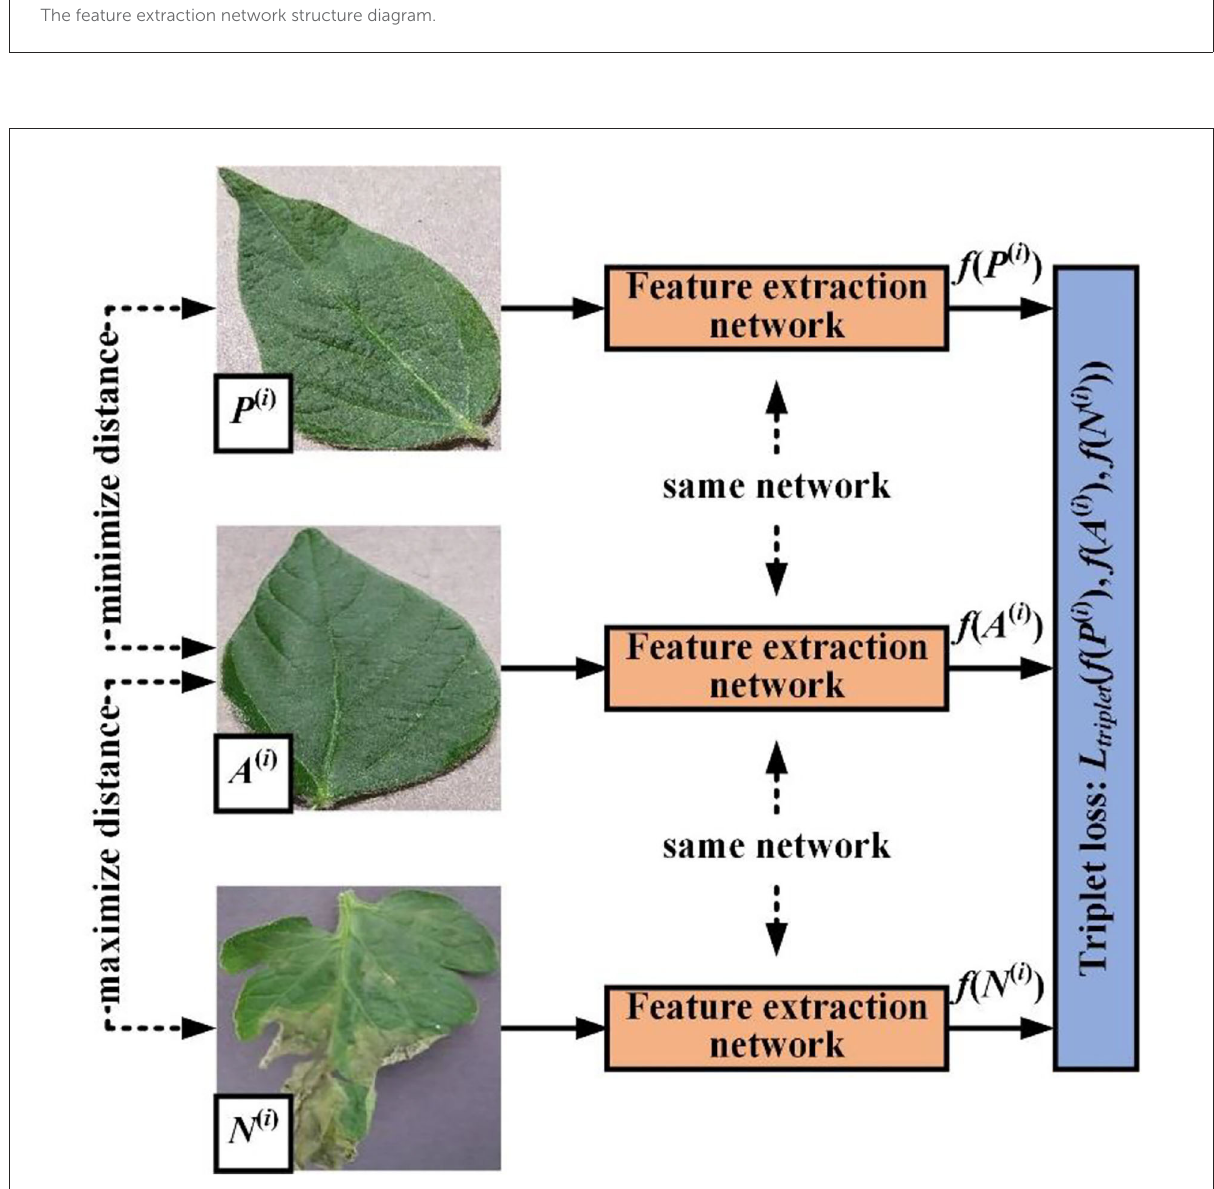
FIGURE6 Sketch of common triplet loss